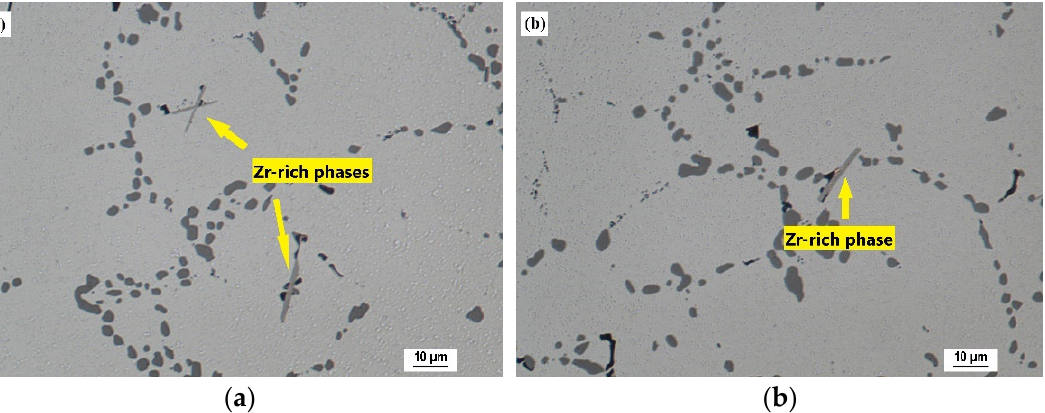
Figure 14. Presence of Zr-rich intermetallic phases after T7 heat treatment (H 2 SO 4 etch.): ( a ) 0.20 wt. % Zr addition; ( b ) 0.15 wt. % Zr addition.